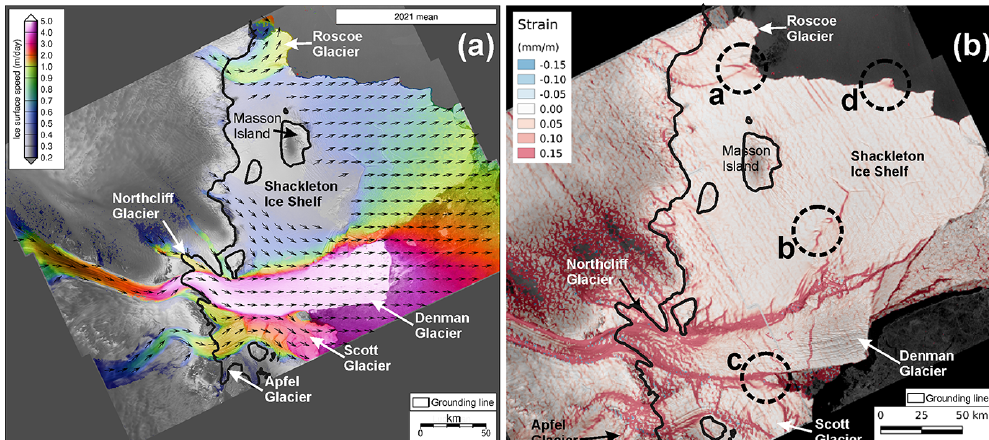
Figure 8. (a) Mean speed for 2022 with velocity arrows. (b) Magnitude of the principal strain rate of Shackleton system derived from Sentinel-1-derived mean velocity data over the period of observation. NB, the area of high strain upstream of Northcliff Glacier is likely noise as filtering was not applied to suppress noise. The feature down-flow of pinning point c on the Denman Tongue is an artefact; we see no evidence of rifting in the remote sensing data in this region (e.g., Figs. 2b,